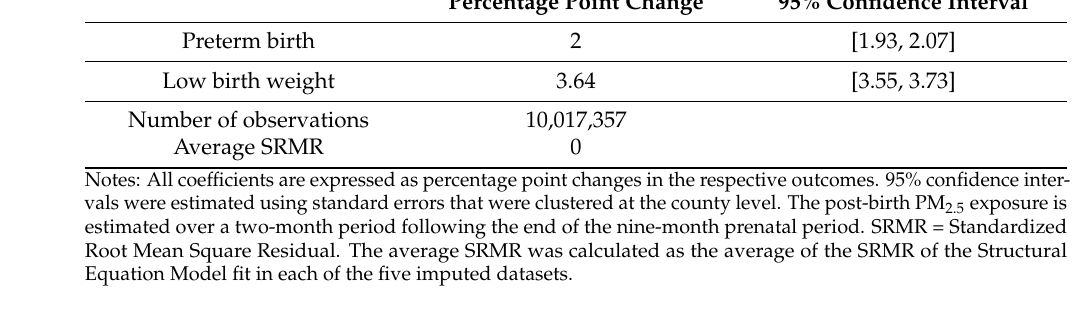
Table A8. Direct and indirect associations of prenatal and post-birth PM 2.5 exposure (defined over 1 month) with infant mortality.